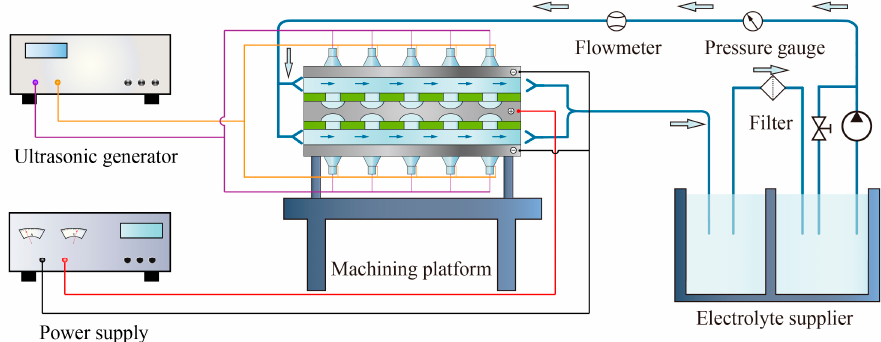
Figure 9. Experimental setup.